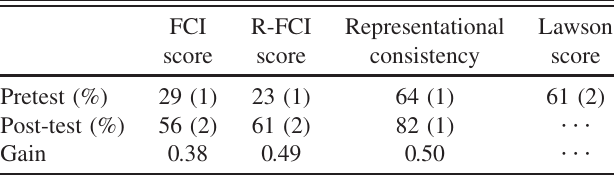
TABLE II. Students’ ( n ¼ 131 ) results in different tests. Means and average normalized gains for test scores and repre- sentational consistency of the R-FCI. Standard error of the mean is in